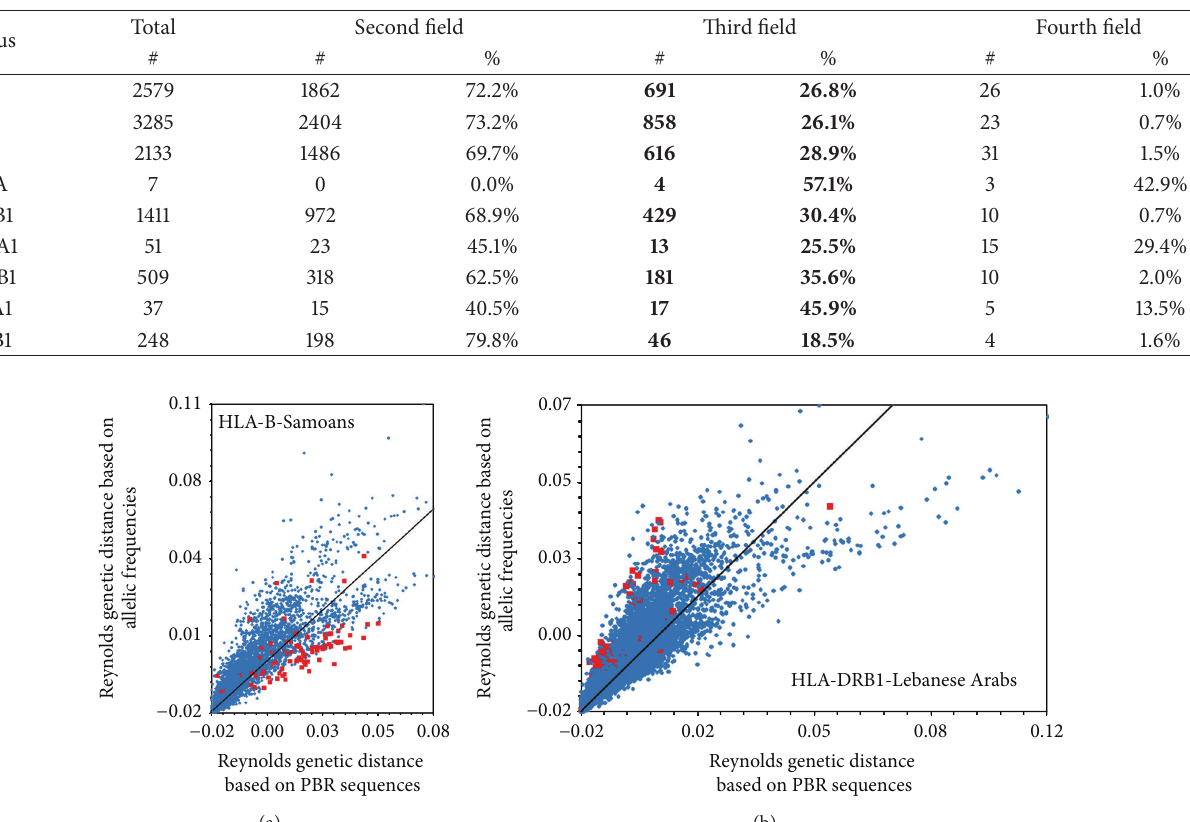
Table 1: Number (#) and proportion (%) of HLA alleles defined at the second, third, and fourth fields of the current HLA nomenclature (IMGT/HLA database release 3.15.0, 2014-01-17). The third field (highlighted in bold) is defined by synonymous nucleotide substitutions in coding regions.